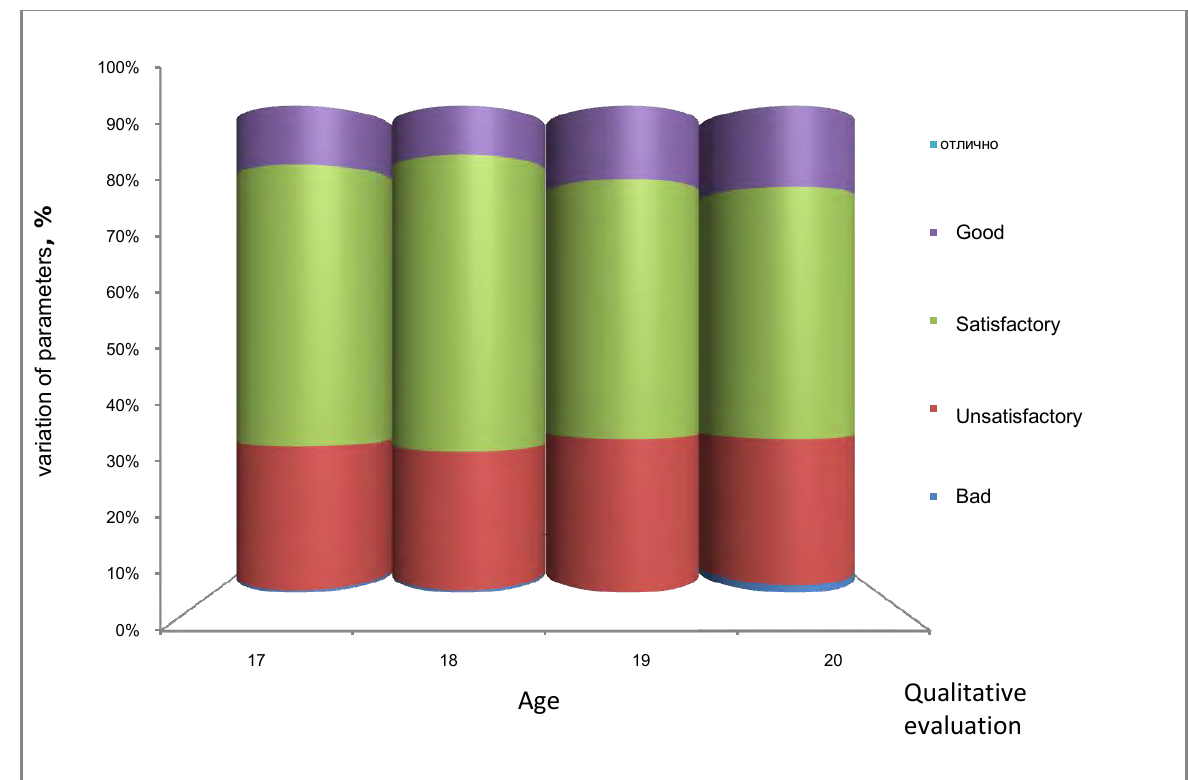
Fig.1. Indicators of complex evaluation of 17-20 years old students power abilities’ development, calculated